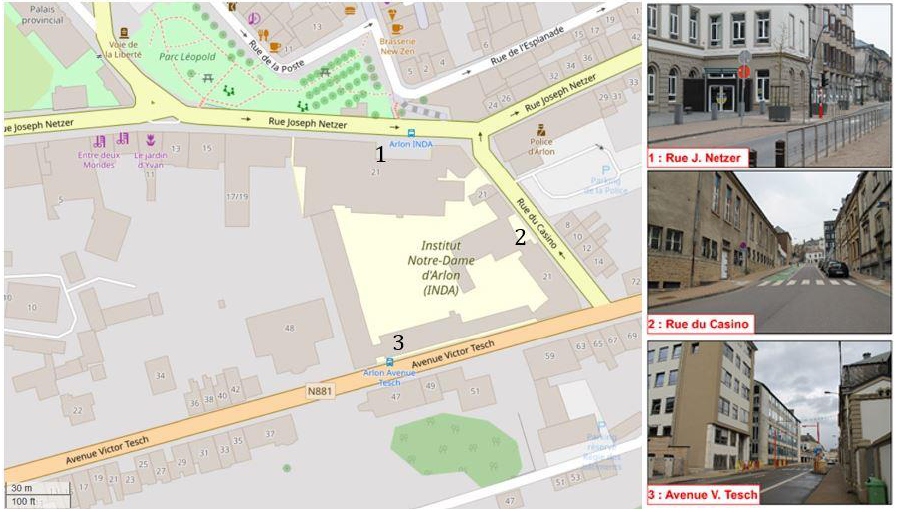
Figure 3. Sampling site: a primary and secondary school in Arlon bounded by three streets [28]. Numbers indicate the position of the sampling devices. Map data © OpenStreetMap contributors, CC BY-SA.